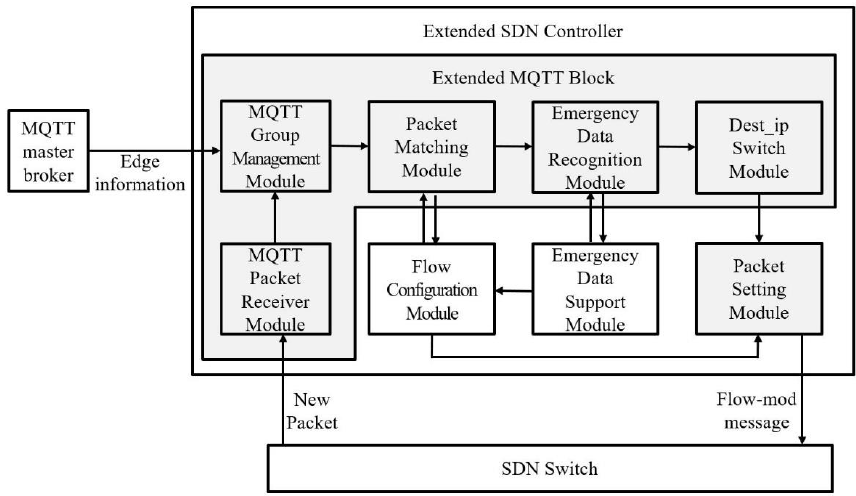
Figure 4. The proposed SDN controller using the extended MQTT block.